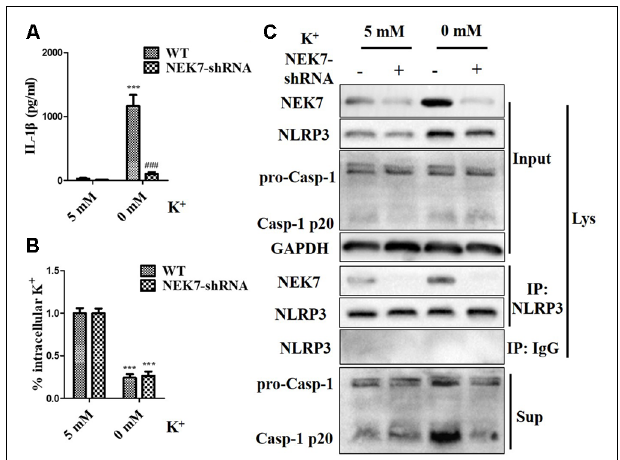
FIGURE 7 | NEK7 knock-down alleviates NLRP3 inflammasome activation-induced K + -free medium. Primary cortical neurons were transduced with NC-shRNA or NEK7-shRNA, and treated with K + -free medium or normal medium. (A) Analysis of intracellular K + in each condition. (B) IL-1 β release was detected. (C) NEK7 and caspase-1 in the supernatant (Sup) and cell lysate (Lys) were analyzed. CoIP analysis of the interaction between NEK7 and NLRP3. Data are represented as the means ± SEM, n = 4. ∗∗∗ p < 0.001, vs. 5 mM group. ### p < 0.001, vs. WT.